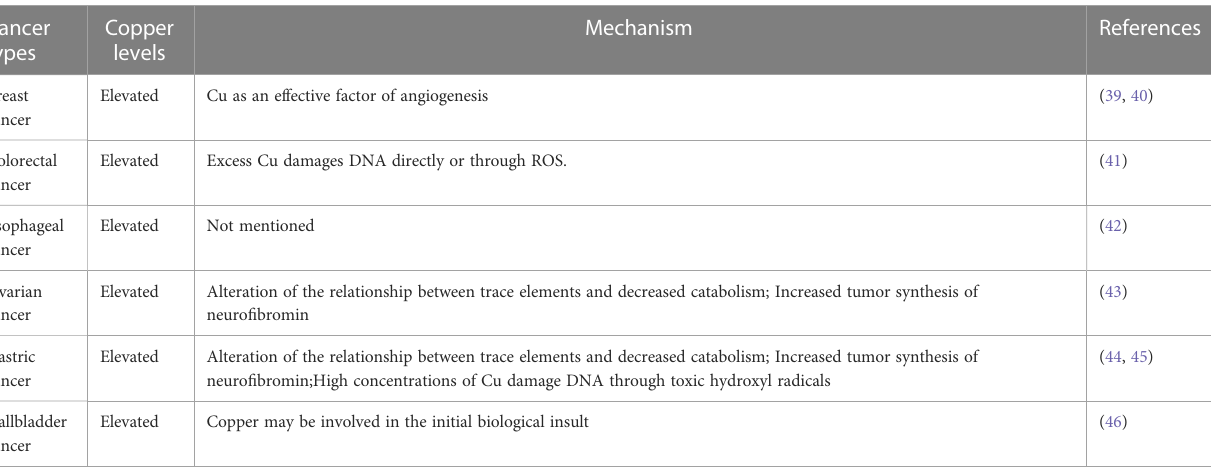
TABLE 1 Copper level variation in cancer tissues among different